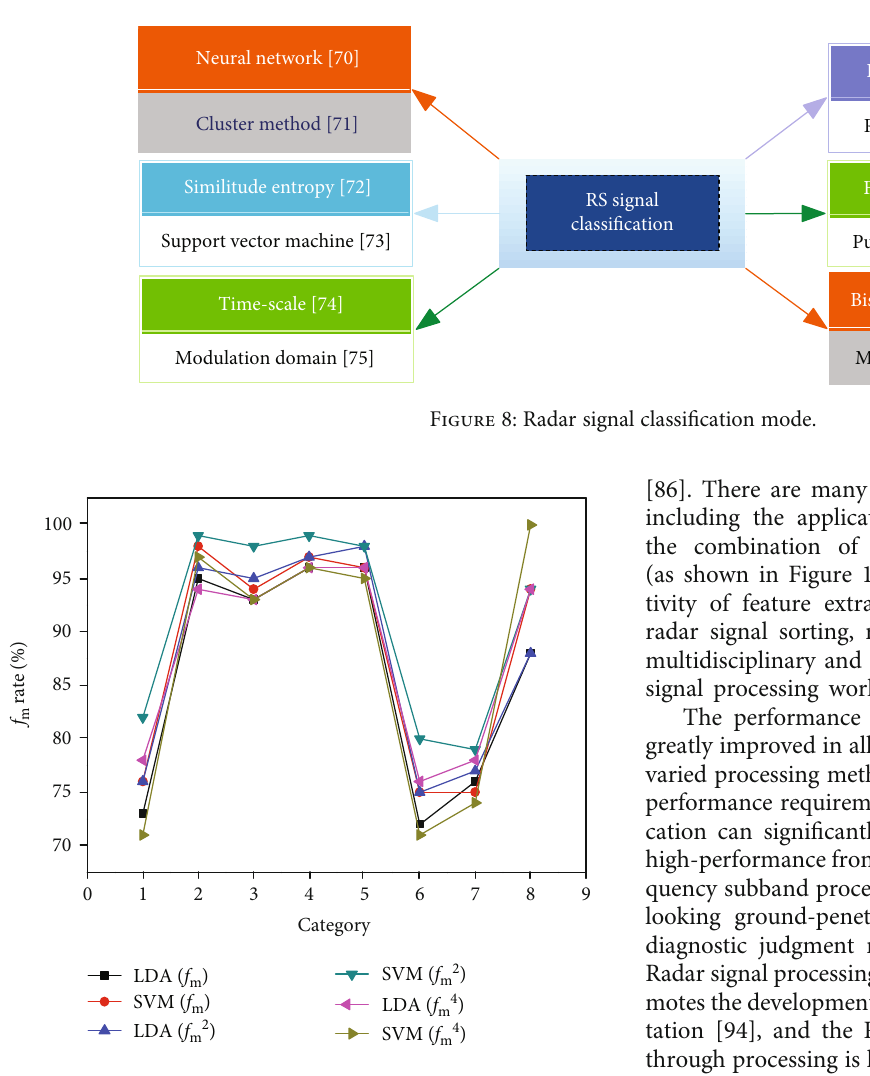
Figure 9: Comparison of recognition rate for di ff erent classi fi ers and categories (the data were obtained from Ref.